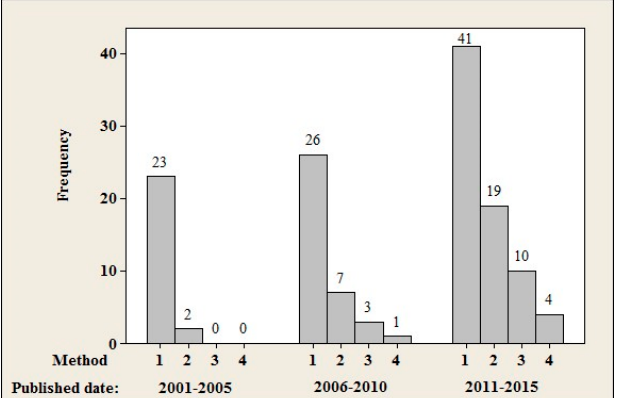
Figure 4. Summary of type of methods using LiDAR data for ITCD (1: raster-based method; 2: point cloud-based method; 3: methods combining raster, point, and a priori information; 4: tree shape reconstruction method) reported in the literature by publication date ( N = 136).